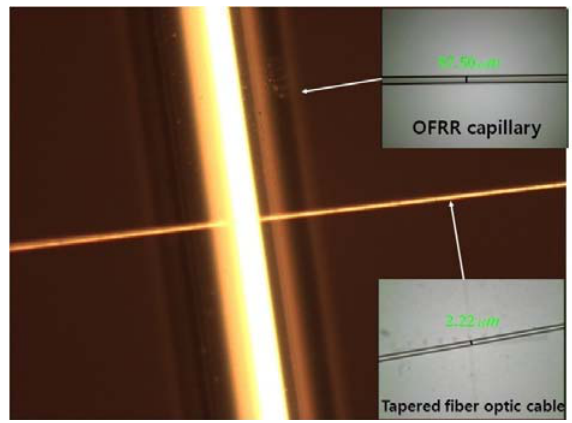
Figure 2. A photograph of a fabricated